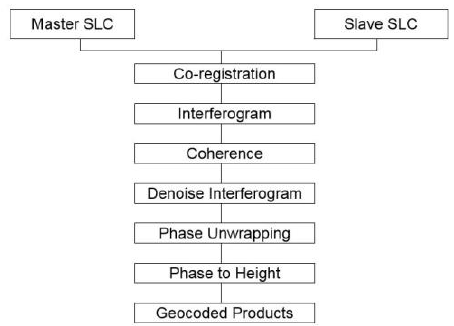
Figure 4. The flowchart of InsSAR DEM generation (Yu et al, 2010) In BIG, these radar data (ORRI and DSM) are generated to produce a stereo model image. An activity to plot or delineate stereo model image using a stereoscopic device, usually in order to produce a 3D map is called